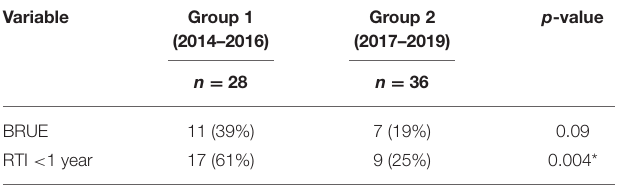
TABLE 5 | Respiratory outcome in group 1 and group